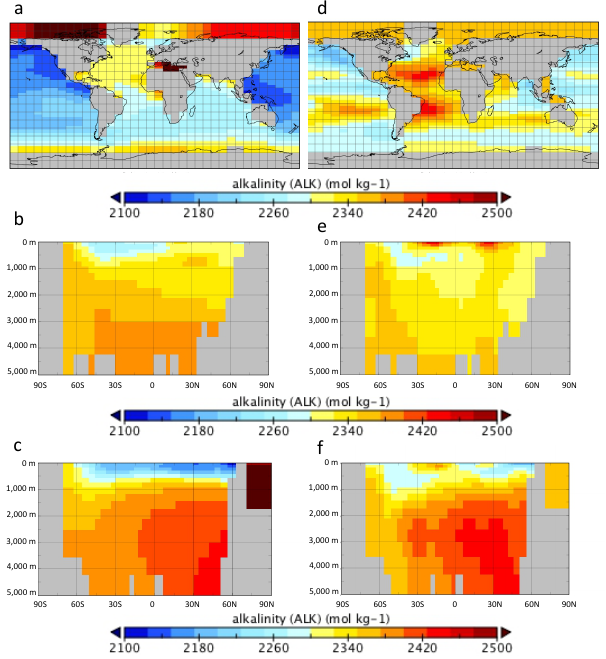
Fig. 7. Alkalinity: (a) , (b) and (c) EFPC ensemble averages, (d) , (e) and (f) observations (Key et al., 2004). Upper panels are sur- face fields ( ∼ 81,m depth). Middle panels are Atlantic cross sec- tions (25 ◦ W). Lower panels are Pacific cross sections (155 ◦ W).